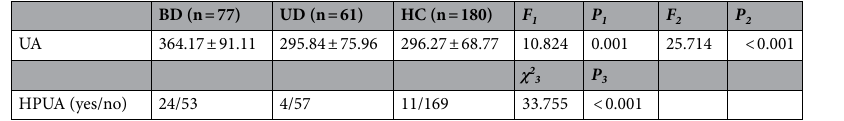
Table 3. UA levels of participants in RS (mean ± SD, μmol/L). UA, uric acid; HPUA, hyperuricemia; UD, unipolar depression; HC, healthy control; SD, Standard deviation. 1 , age, sex, history of smoking, family history, age of onset, mood episode numbers, duration of disease, whether with psychotic symptom and lipid indices as covariates between BD and UD groups. 2 , age, sex, history of smoking and lipid indices as covariates among 3 groups. 3 , compare the number of participants with HPUA among BD, UD and HC groups.